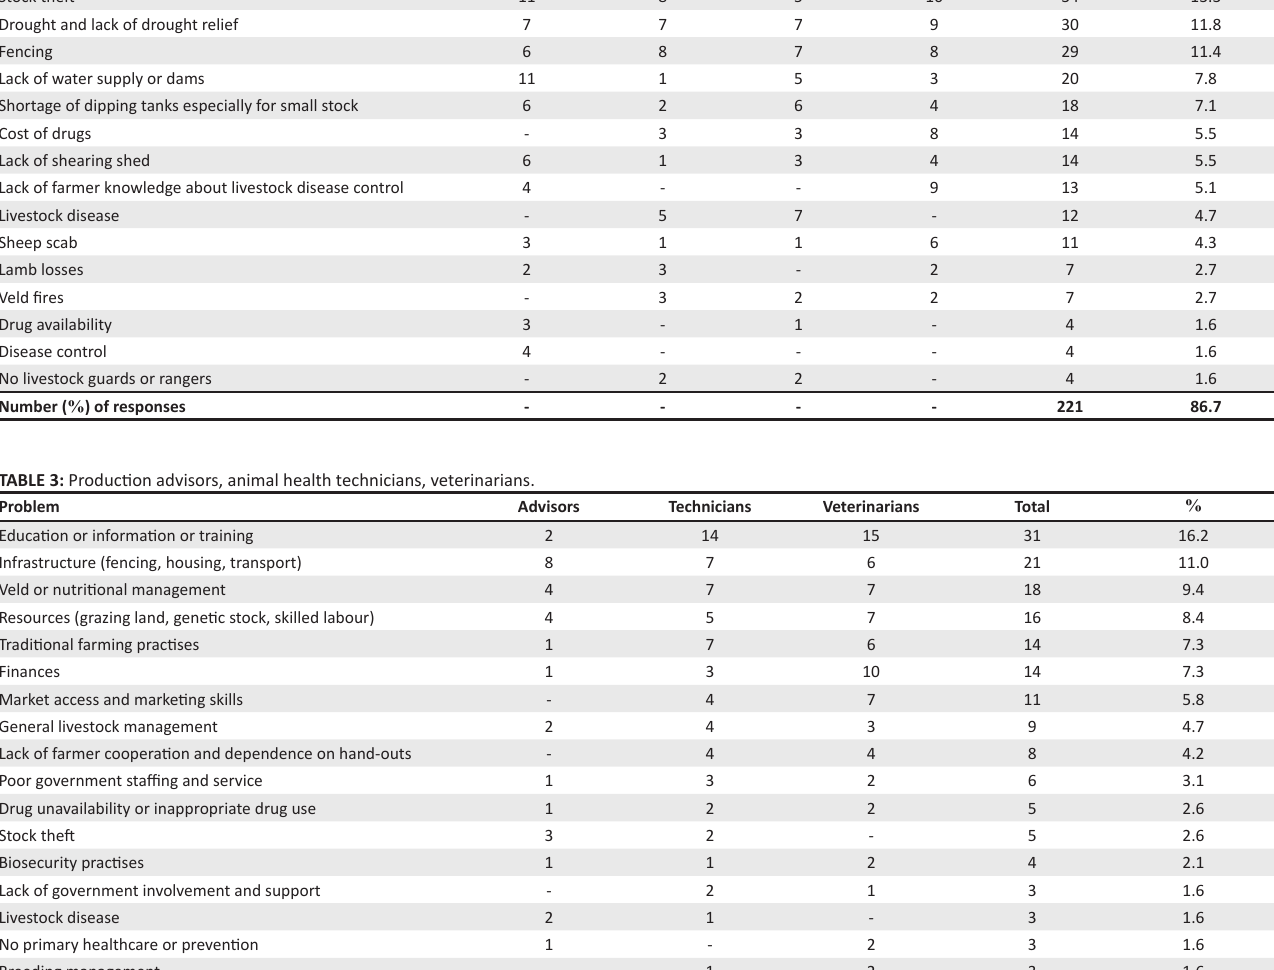
TABLE 2: Difficulties and constraints: Those with four or more responses communities of farmers. Problem